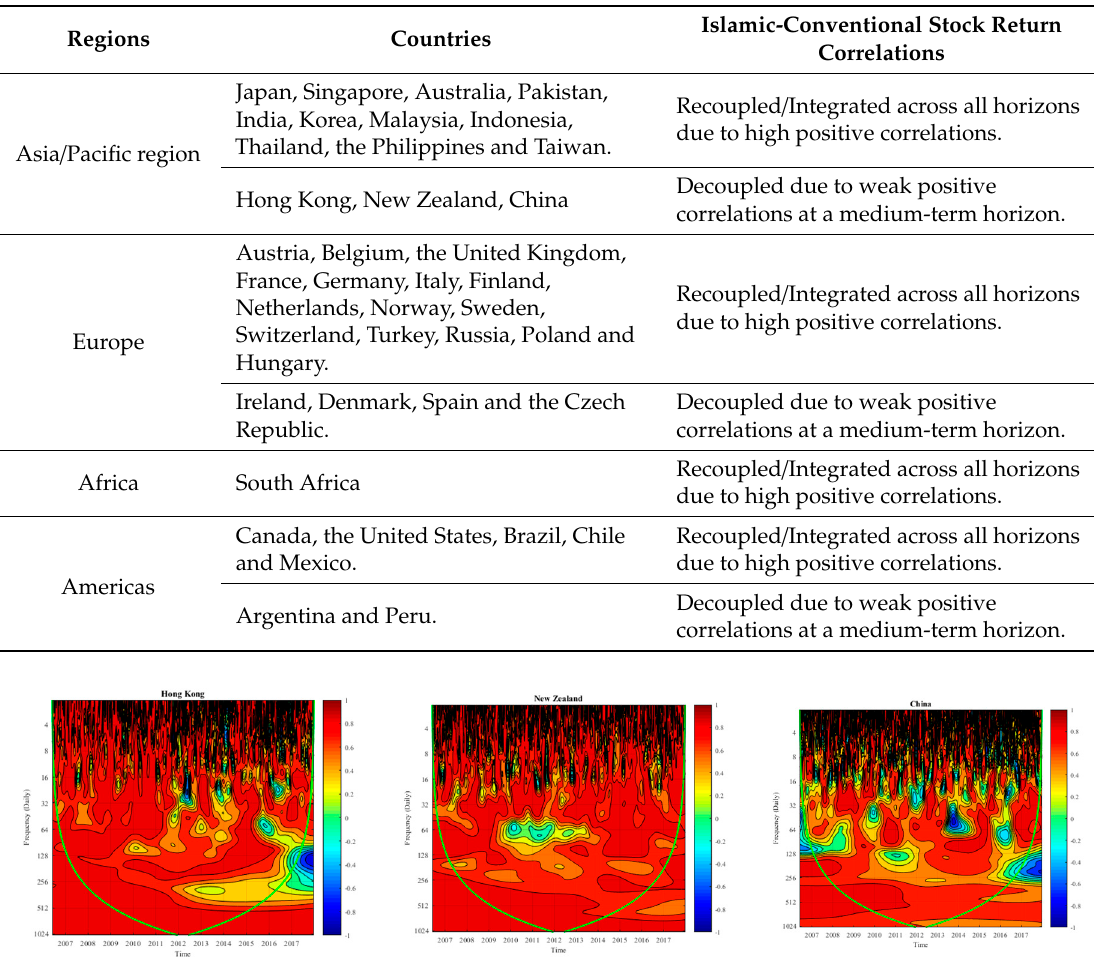
Table 5. Summary of the Islamic and Conventional Stock Return Wavelet Correlations.